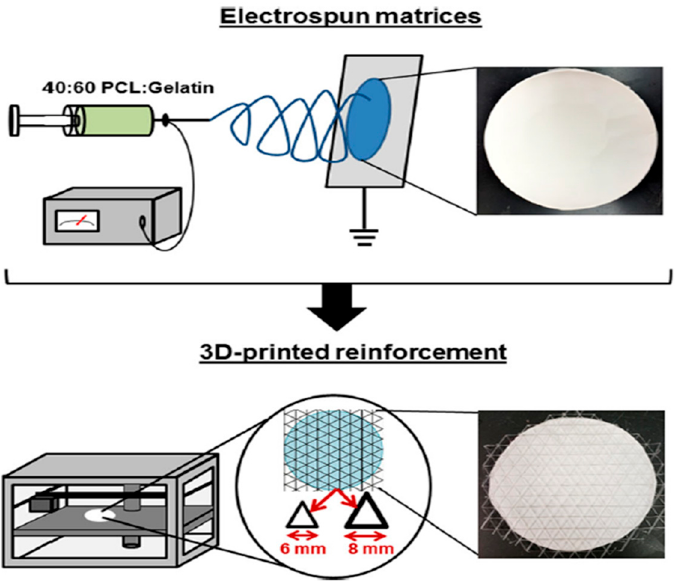
Figure 17. Fabrication of reinforced electrospun scaffolds. Electrospun scaffolds were produced from a 40:60 ratio of PCL:gelatin. The scaffolds were then placed in a 3D printer, and a PLA mesh was deposited onto one side of the scaffold. Two types of 3D-printed meshes were generated: one with a 6 mm distance between PLA struts, and the other with an 8 mm distance between struts (adapted with permission from [274]).